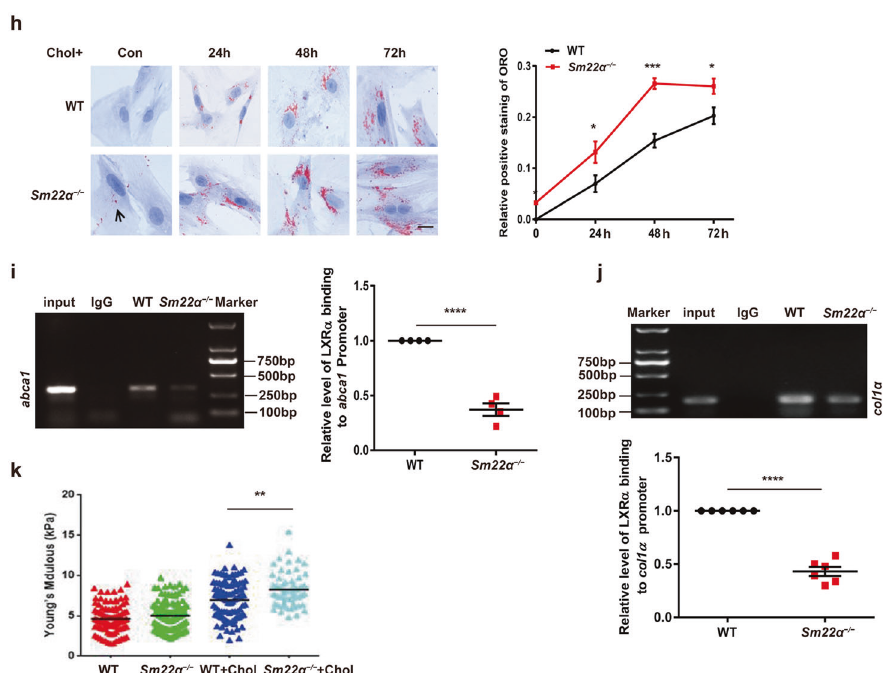
Fig. 3 Function of the LXR. α -ABCA1 axis is impaired in phenotypically switched VSMCs. a Heatmap of proteomic analysis between synthetic and contractile VSMCs. b Analysis of KEGG pathway enriched by differentially expressed genes of proteomic analysis between synthetic and contractile VSMCs. c The mRNA expression of SM22 α , LXR α , and ABCA1 in WT VSMCs treated with PDGF-BB for 0, 12, 24, and 48 h respectively ( n = 3). d Confocal microscopy images of LXR α distribution in WT VSMCs incubated with PDGF-BB for 0, 12, 24, and 48 h respectively. Scale bar, 10 µm. e Confocal microscopy images of LXR α and ACTA2 in arterial walls of WT mice after ligation for 0, 7, 14, and 28 days. Scale bar, 20 µm. f Quanti fi cation of each lipid class in synthetic and contractile VSMCs. Lipid classes were expressed as μ mol per g protein. g Heatmap of CEs between synthetic and contractile VSMCs. h ORO staining of WT VSMCs transducted with or without Ad-GFP- SM22 α following with PDGF-BB and/or cholesterol treatment and quanti fi cation of positive ORO staining. Scale bar, 20 μ m ( n = 3) i M-mode and Doppler echocardiography images obtained from aortic arch and out fl ow tract of Sm22 α − / − mice transducted with AAV-GFP ( n = 10) and AAV-SM22 α ( n = 10) fed Paigen diet for 12 weeks. A s : out fl ow tract and aortic diameter in systole; A d : out fl ow tract and aortic diameter in diastole. j Representative images of en face ORO-stained aortas and quanti fi cation of lesion areas ( n = 6). k Representative immuno fl uorescence of LXR α (green) and quanti fi cation of cells with nuclear LXR α in the aortic sections from Sm22 α − / − mice transducted with AAV-GFP ( n = 4) and AAV-SM22 α ( n = 4) fed Paigen diet for 24 weeks. Scale bar, 10 µm. Arrows indicated the distribution of LXR α . l Identi fi cation of SMC-derived foam cells within atherosclerotic lesion of Sm22 α − / − mice infected with AAV-GFP ( n = 4) and AAV-SM22 α ( n = 4) fed Paigen diet for 24 weeks by CD68 (blue), ACTA2 (red) and Bodipy (green). Scale bar, 25 µm. Arrows indicated foam cells that were VSMCs- derived. Data and images are representative of at least three independent experiments. Data in ( c ) were analyzed by two-way ANOVA. Data in ( f ), ( h ), ( j ), ( k ) and ( l ) were analyzed by unpaired t test. * p < 0.05; ** p < 0.01; *** p < 0.001; **** p < distributed in the nucleus of the medial VSMCs in the normal the expression of SM22 α , ABCA1 and LXR α mRNAs decreased in a artery, whereas LXR α localization was shifted from the nucleus to time-dependent manner in PDGF-BB-induced VSMCs (Fig. 3c). the cytoplasm and merged with ACTA2 in the neointima VSMCs Notably, LXR α was gradually shifted from the nuclear to the undergoing phenotypic modulation (Fig. 3e), indicating that LXR α cytoplasm in some VSMCs with extended PDGF-BB stimulation nuclear localization was disturbed in these modulated VSMCs. To time (Fig. 3d). To determine whether nuclear localization of LXR α is further con fi rm the effect of reduced LXR α -ABCA1 activity on lipid impaired in modulated VSMCs in vivo, we examined VSMCs in the metabolism, the lipid pro fi les of VSMCs treated with PDGF-BB were media and the neointima of mice. As expected, LXR α was mainly